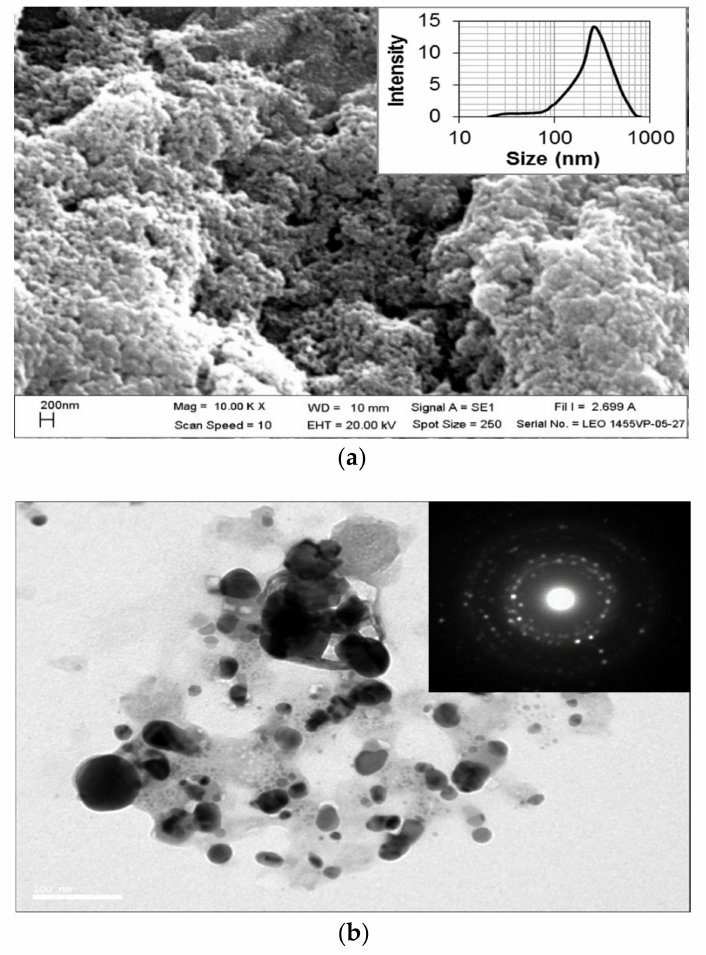
Figure 2. Scanning electron microscopy ( a ); and transmission electron microscopy images of Ag/AgCl-G ( b